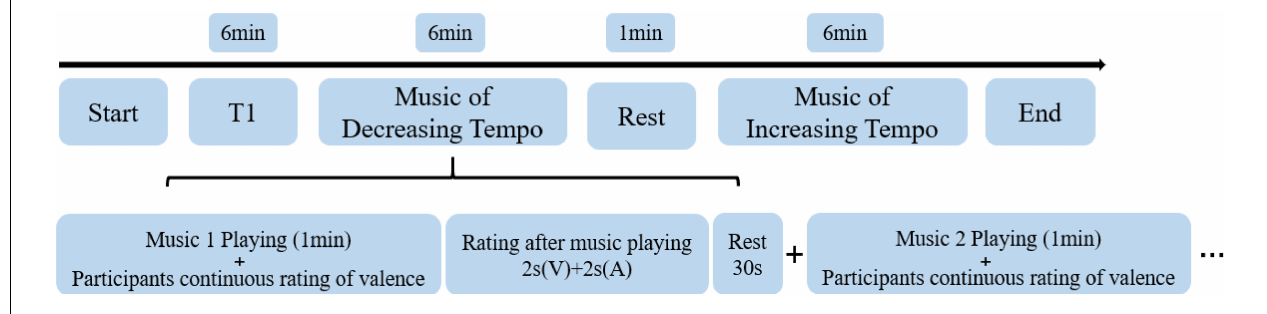
FIGURE 1 | The procedure of fMRI scanning. V, valence; A, arousal.